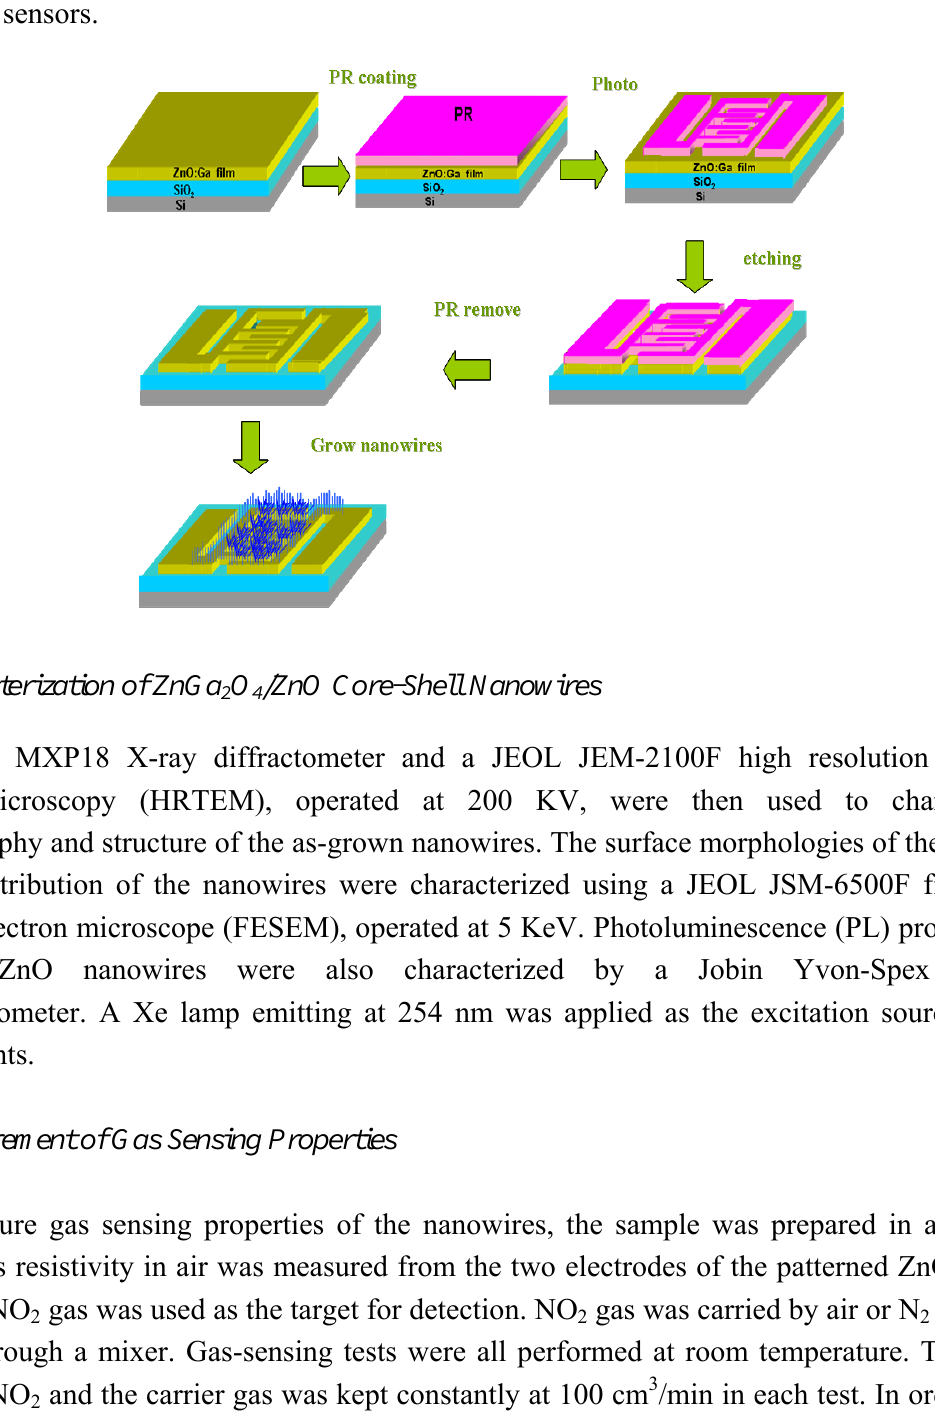
O /ZnO core-shell nanowire 2 4